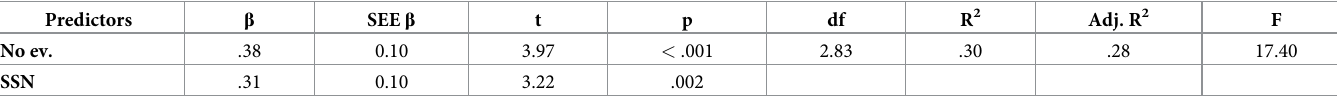
Table 7. A summary of the results of the backward stepwise linear regression with the IES-R total score as a dependent variable, and male role norms, social rela- tions/support, and sociodemographic and trauma-related data as independent variables. Predictors β SEE β t p df R 2 Adj. R 2 F No ev. .38 0.10 3.97 < .001 .28 17.40 SSN .31 0.10